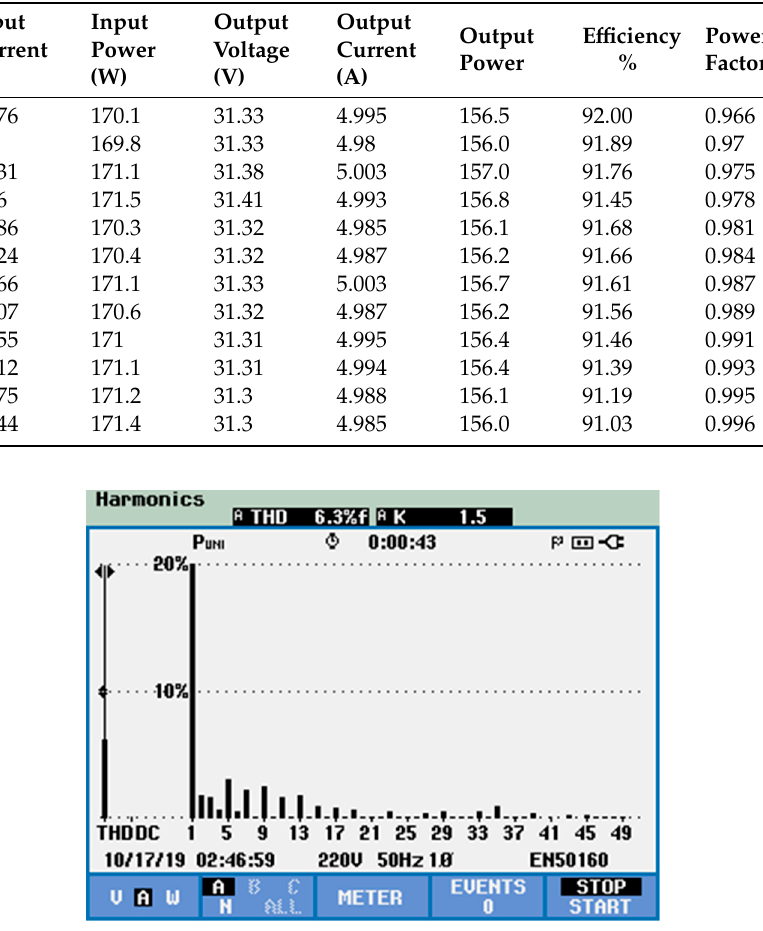
Figure 20. Experimental results of output voltage / current. Table 7. Experimental results of input / output performance of 150 W two-stage LED driver.